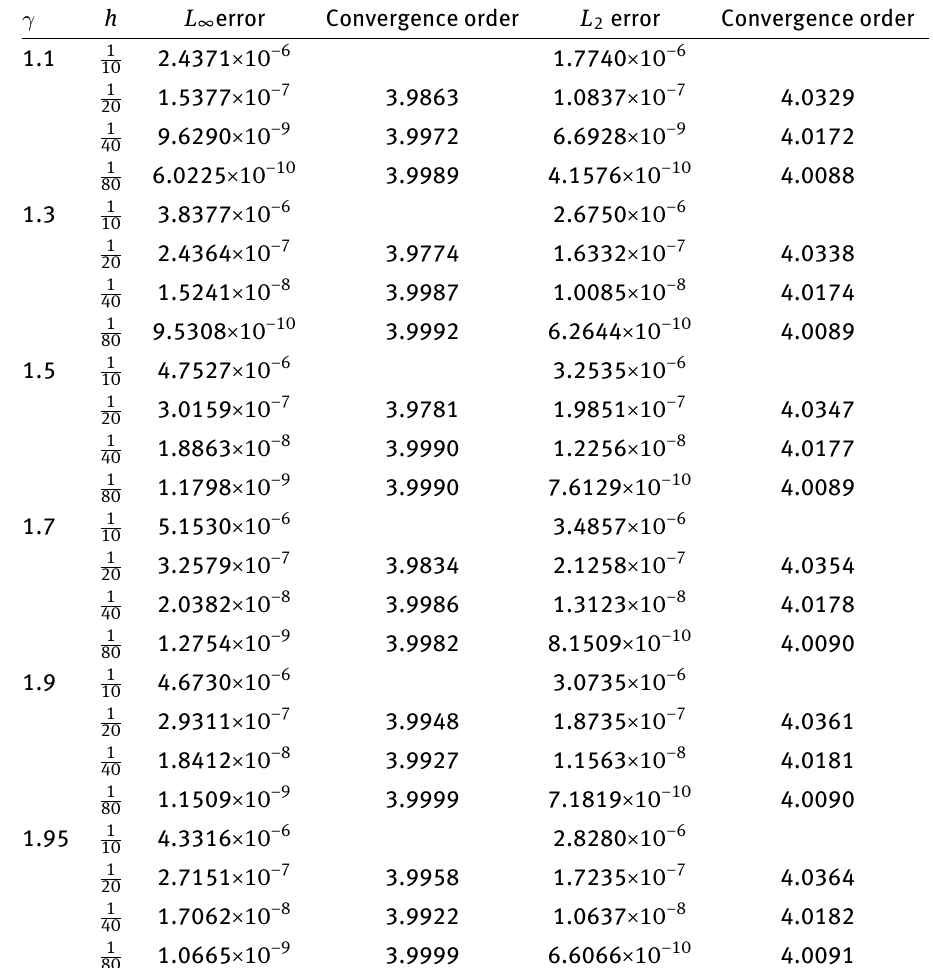
Table 2: The L ∞ , L 2 errors and spatial convergence orders with τ = h 2 for Example 1. γ